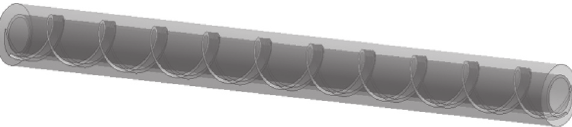
Figure 4: Flow model of interior of slag discharge